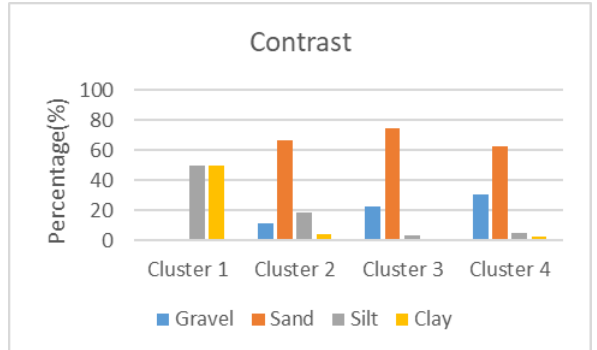
Figure 10: Per cluster sediment composition percentage for